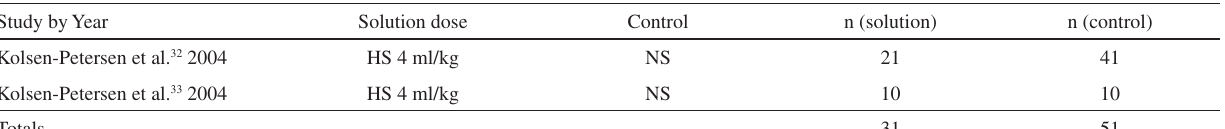
Table 4 - Perioperative studies on the use of hypertonic saline (7.2 -7.5% NaCl) compared to normal saline (NS) in abdominal